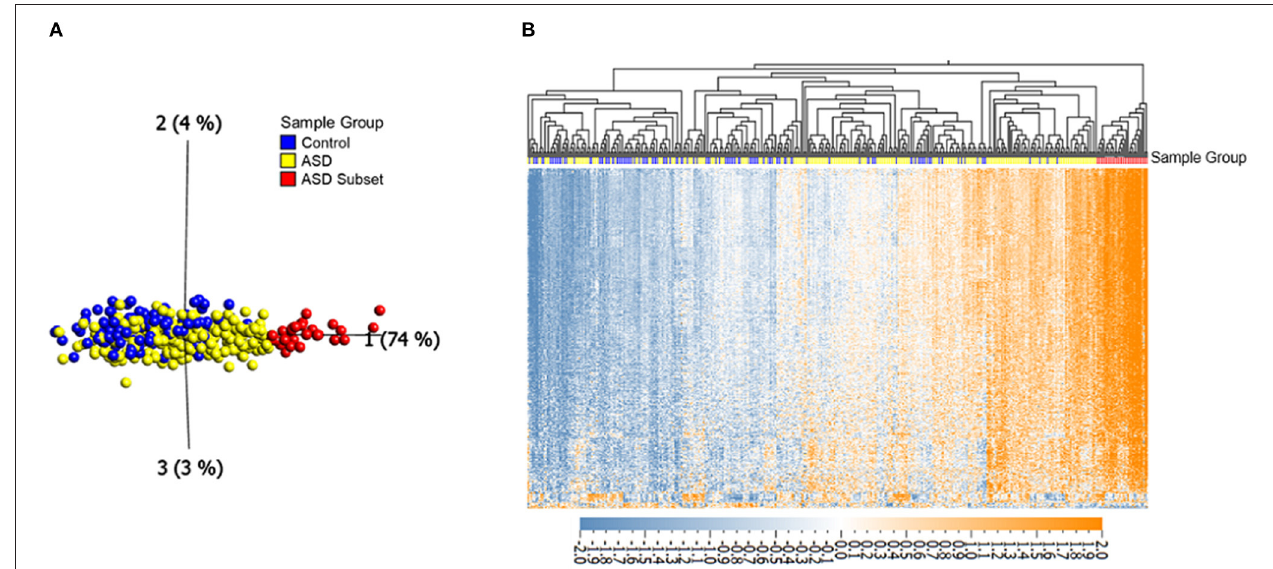
FIGURE 1 | Differential DNAm at 400 in ASD ( n = 265) and neurotypical controls ( n = 122) reveals an epigenetically unique subset of ASD cases ( n = 32). (A) Principal component analysis performed on 400 CpGs (FDR adjusted p -value < 0.01 and | 1 β | > 5%), with axes representing first three principal components. (B) Corresponding heatmap hierarchical clustering using Eucledian distance metrics. Orange indicates high DNAm, and blue gray indicates low DNAm, normalized for visualization (mean = 0, variance = 1). Samples labeled with red and yellow represent the ASD subset and the remaining ASD cases, respectively, blue samples represent